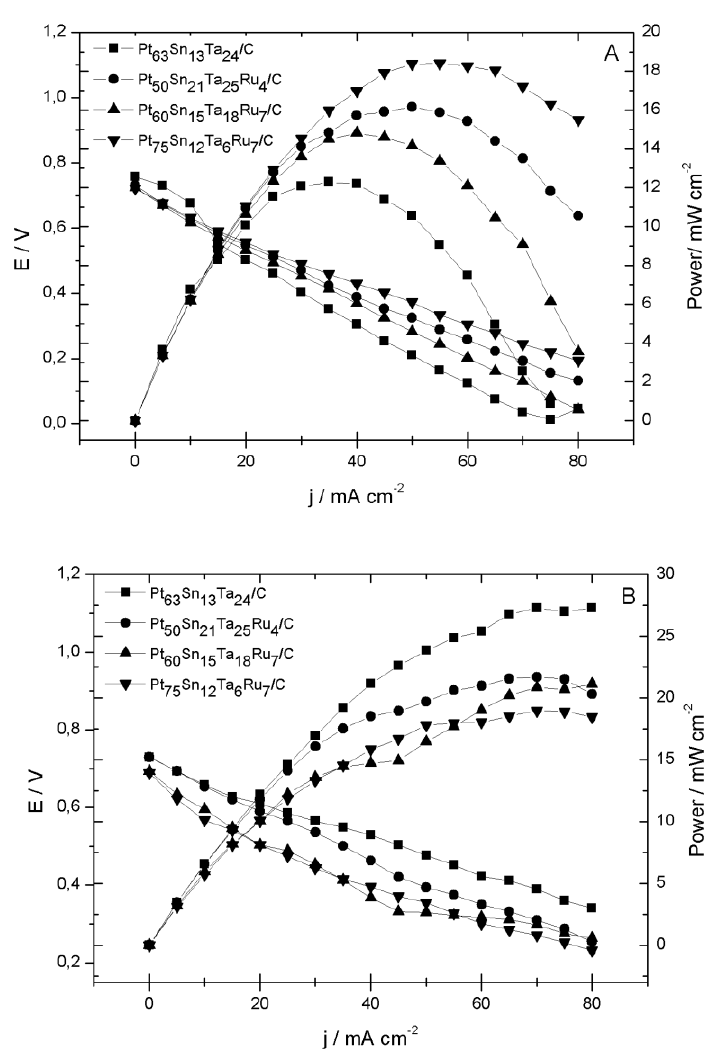
Figure 6. Ethanol fuel cell tests, operating at 90 ◦ C with a fuel flow of 2.0 mL min − 1 , O 2 pressure of 3 bar and pressure of 1 bar of ethanol with a metal loading of 2.0 mg cm − 2 in the anode and cathode of Pt, 2.0 mg Pt cm − 2 , for the different catalysts. ( A ) Ethanol 2.0 mol L − 1 , ( B ) ethanol 2.0 mol L − 1 in H 2 SO 4 0.5 mol L − 1 .